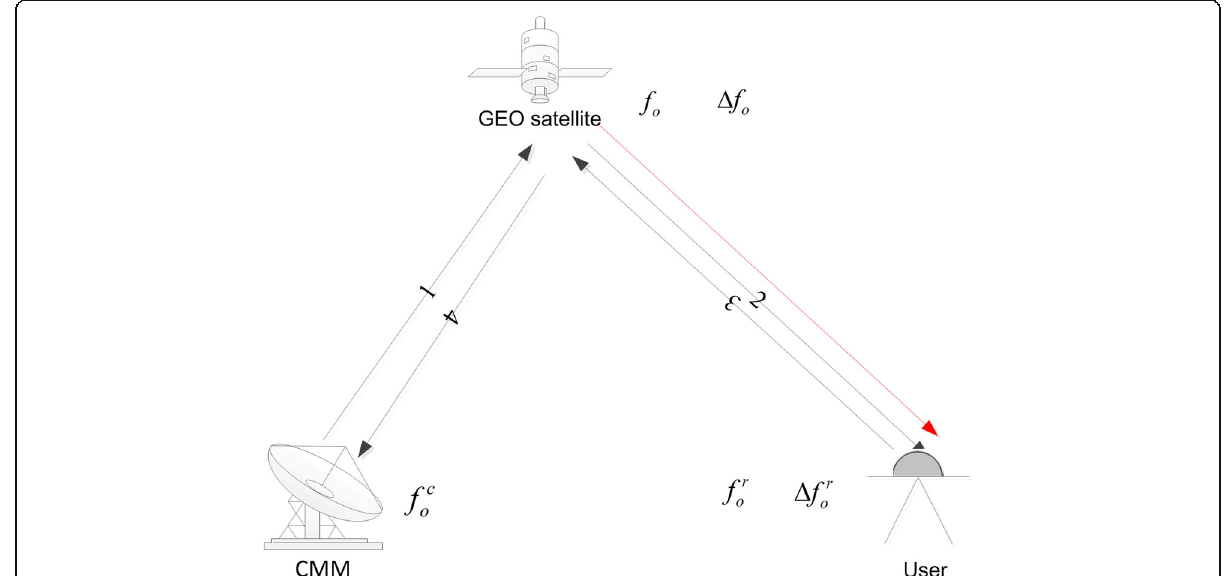
Fig. 5 Precise time and frequency transmission between MCS and